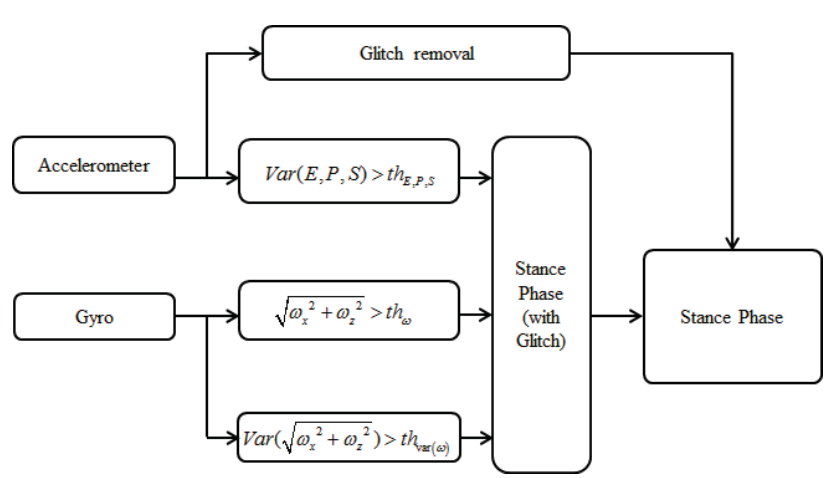
Figure 7. Block diagram of the stance-phase detection algorithm.